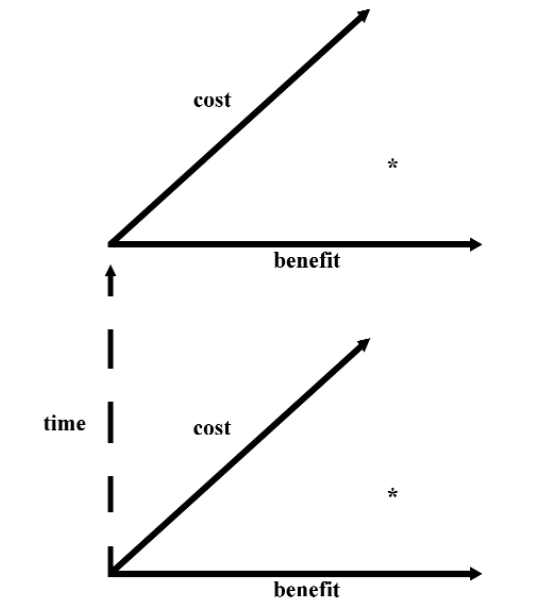
Figure 2. Long-term cost-benefit ratio in the geoethical